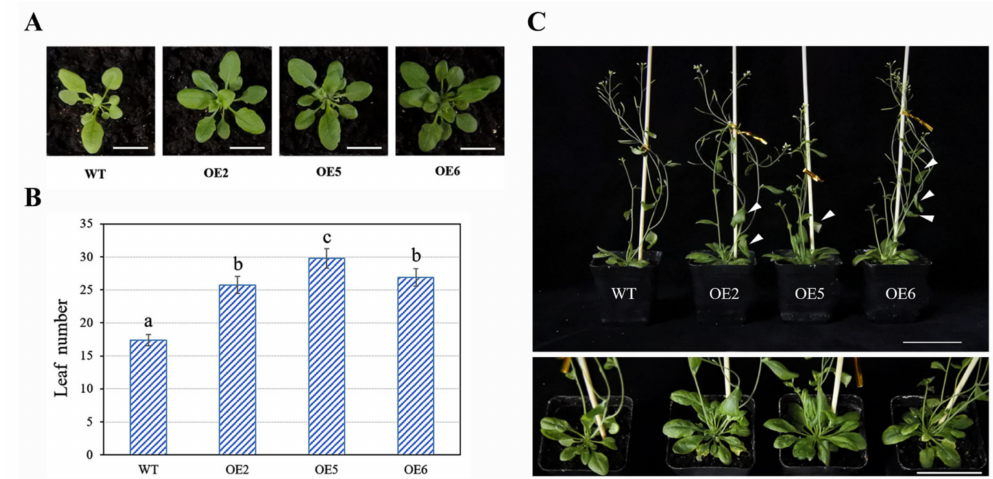
Figure5. Phenotypeof BcMYB101 overexpressionin Arabidopsis .( A )Leafnumberdi ff erenceofwild-type (WT) and transgenic plants overexpressing BcMYB101 . Scale bar = 2 cm. ( B ) Rosette leaf number at bolting in the WT and BcMYB101 -overexpressed lines OE2, OE5, and OE6. Error bars represent the standard deviation of the mean number of 20 plants for each line. ANOVA was used for statistical analysis. Letters (a, b, c) indicate the di ff erence of leaf number in WT and BcMYB101 -overexpressed plants. ( C ) Phenotype of downward-curling cauline leaves and higher leaf number in transgenic lines; the top view of the leaf is displayed at the bottom. Scale bar = 5 cm.